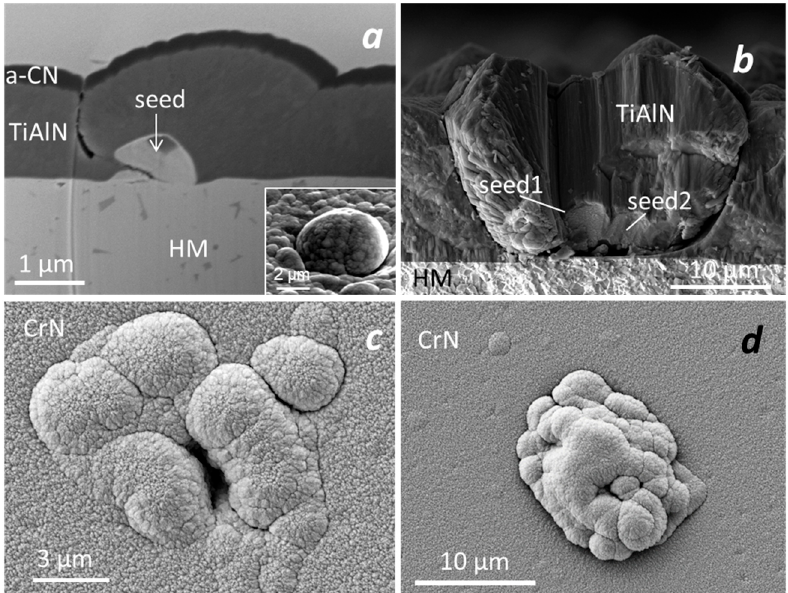
Figure 11. The material deposited on one seed forms a single nodular defect ( a ), while the material deposited on two or more close-spaced seeds forms conjoined nodular defects ( b ). Nodular defects can appear together in complex aggregates ( c ) or with a typical “cauliflower-like structure” ( d ). Nanolayer nl-TiAlN/CrN ( a ) and TiAlN ( b ) hard coatings were prepared by sputtering, while evaporation using thermionic arc was used for deposition of CrN hard coating ( c , d ).